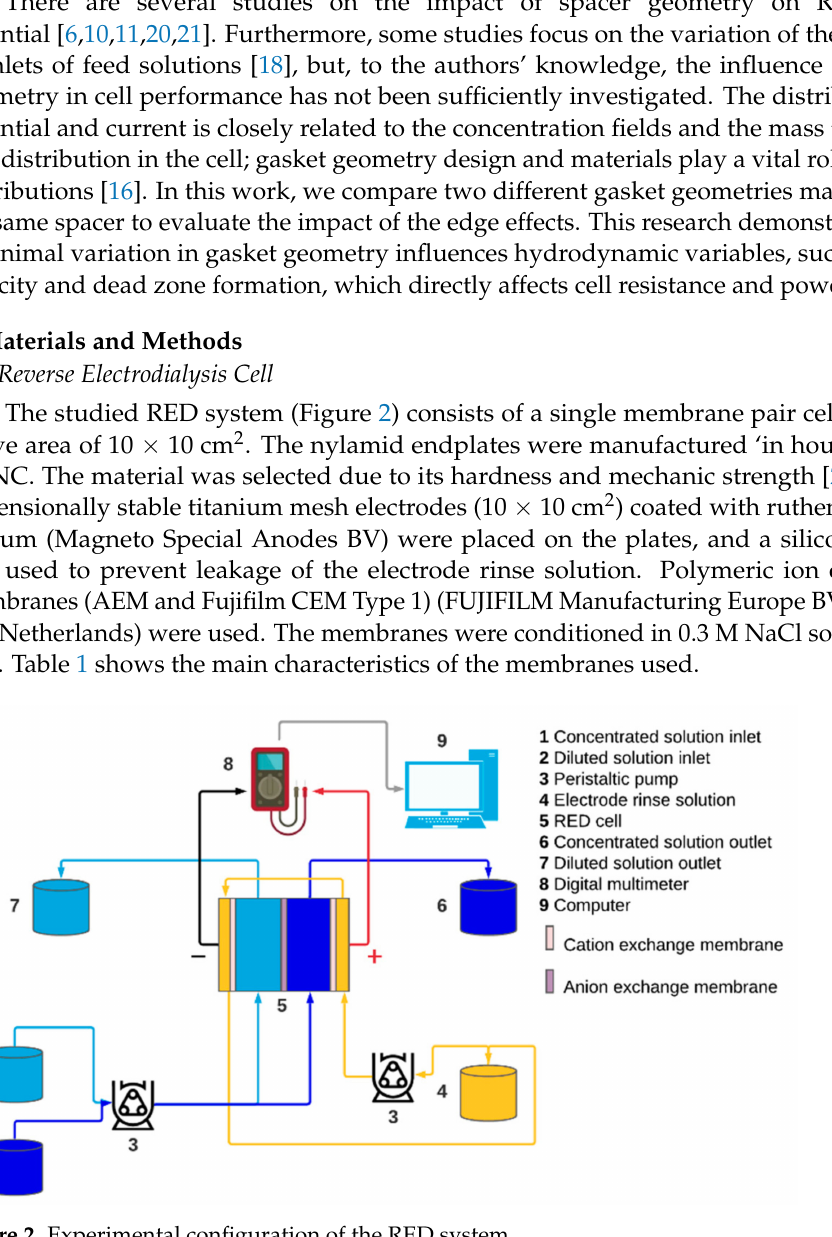
Figure 2. Experimental configuration of the RED